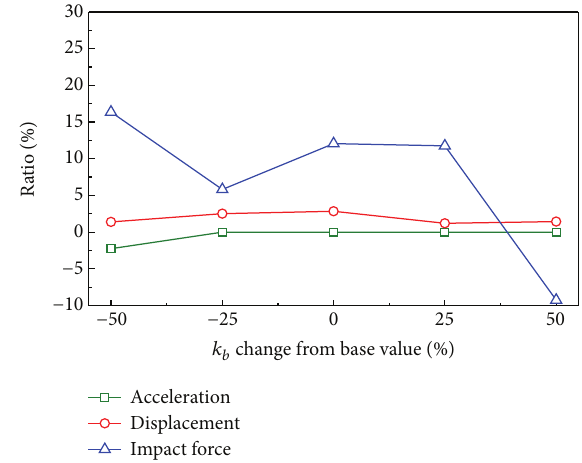
Figure 12: Effect of changing isolation layer spring stiffness on structural